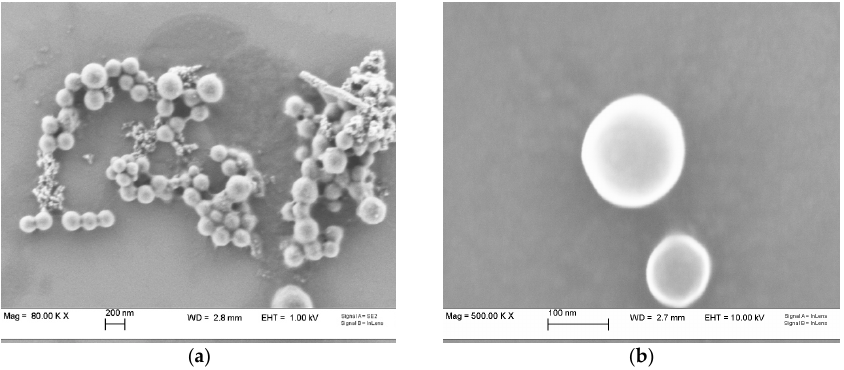
Figure 1. Scanning electron microscopy (SEM) images of the chitosan/lecithin nanoparticles: at 80 K× ( a ) and 500 K× ( b ) magnification.